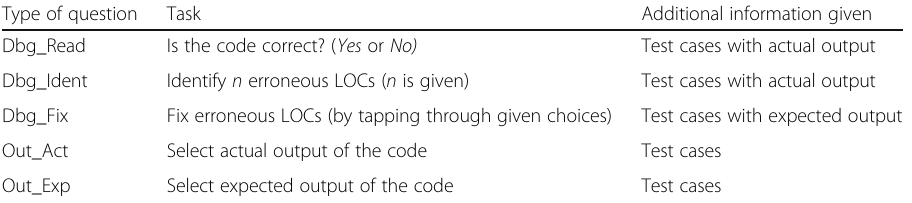
Table 1 Five types of debugging and output prediction activities in